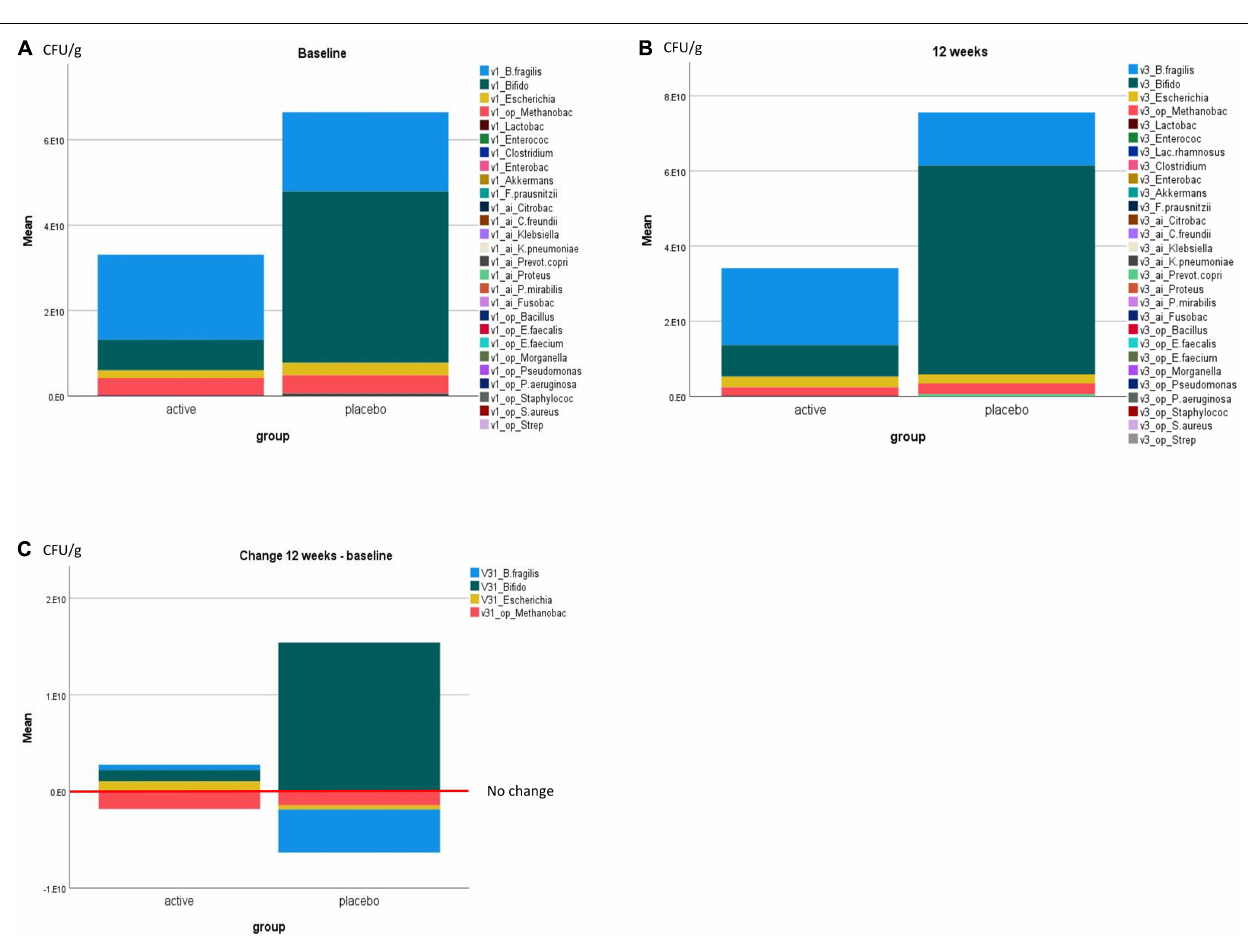
FIGURE 5 | Microbial richness/number of bacteria in CFU/g by the trial group at (A) baseline, (B) 12 weeks, and (C) change at 12 weeks compared with baseline. All bacterial species tested for are listed in (A,B) , and only bacterial species with visible changes are displayed in (C)